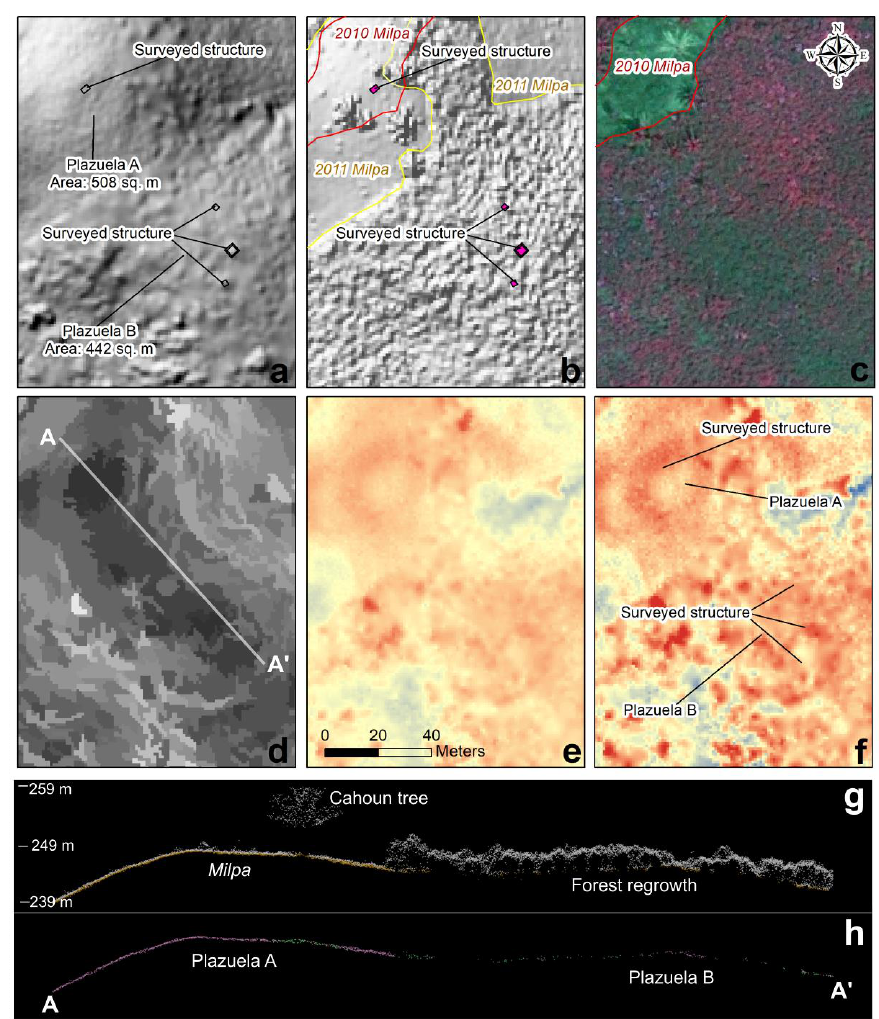
Figure 9. An example of the impact of vegetation on the relief visualization of small plazuelas from Uxbenká Settlement Group 83. ( a ) The location of structures and the location and size of Plazuelas A and B on a lidar hillshade DTM in comparison to ( b ) 2011 milpas and forest areas on the lidar DSM.